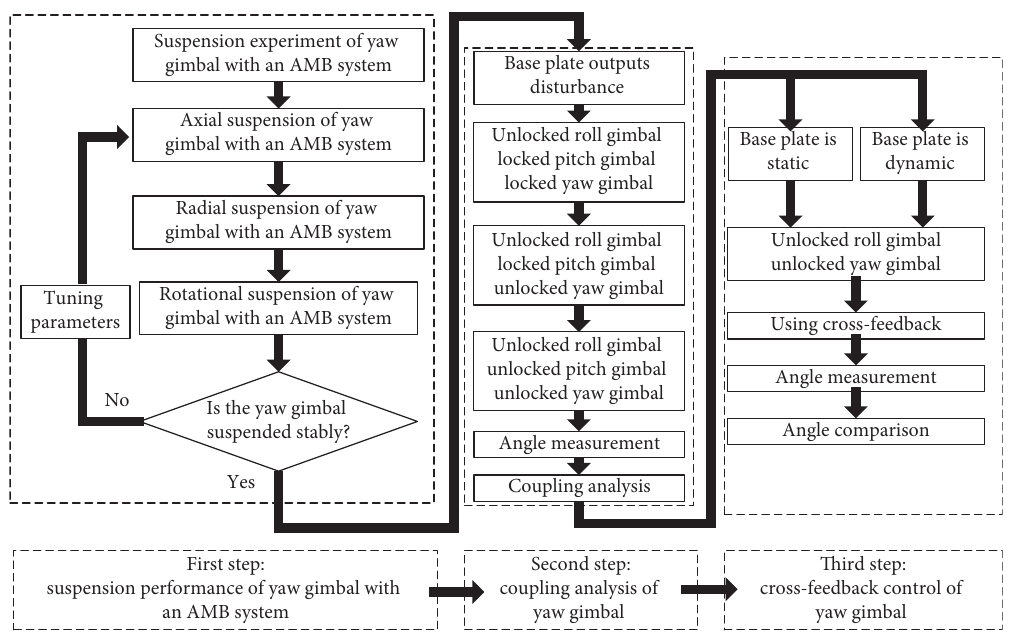
Figure 12: Experimental